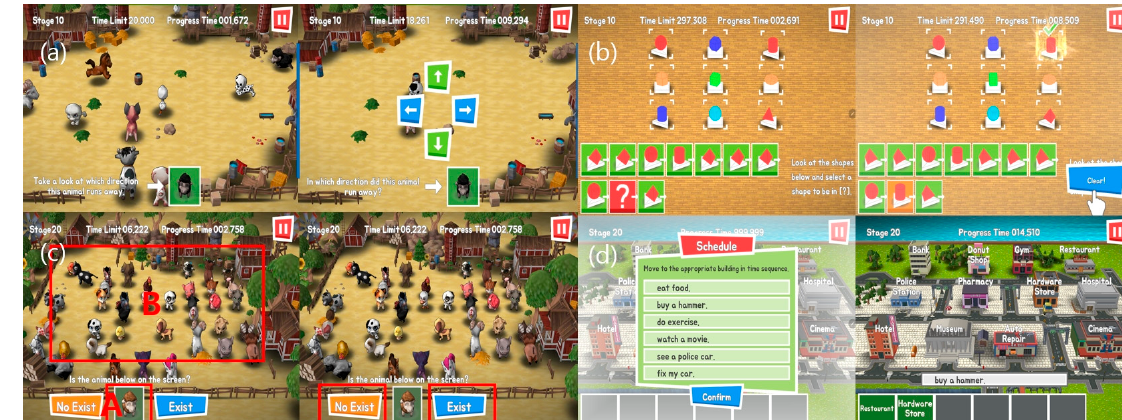
Figure 2. Examples of game progression screen in the Neuro-World cognitive training program. ( a ) Visual perception memory (Level 10), ( b ) selective attention concentration (Level 10), ( c ) search and observation (Level 20), ( d ) daily task planning (Level